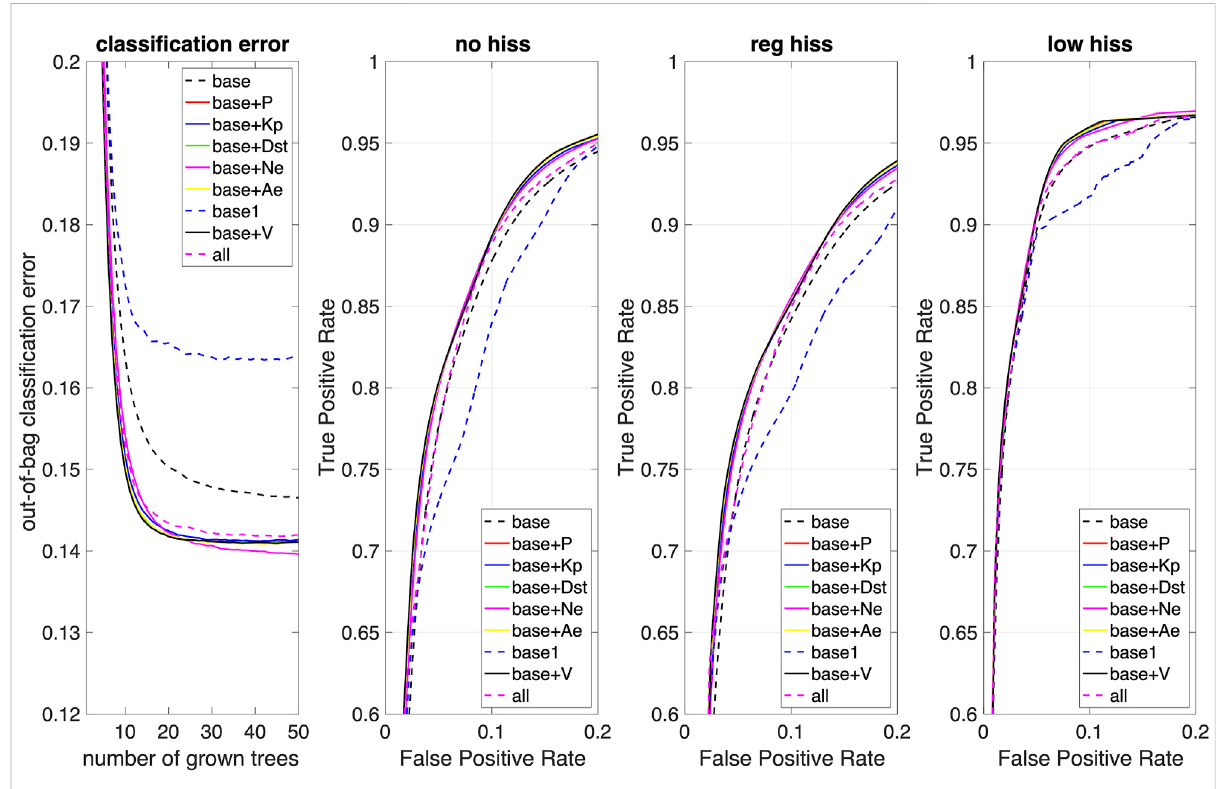
FIGURE 3 Overall classi fi cation error and receiver operating characteristic (ROC) curves (zoomed in) for predicting speci fi c spectral classes of plasmaspheric hiss by random forest models using different predictors; “ base ” model — (MLAT, MLT, L); “ base1 ” model — (MLAT, MLT, Lpp, dL) predictors; “ all ” model - all